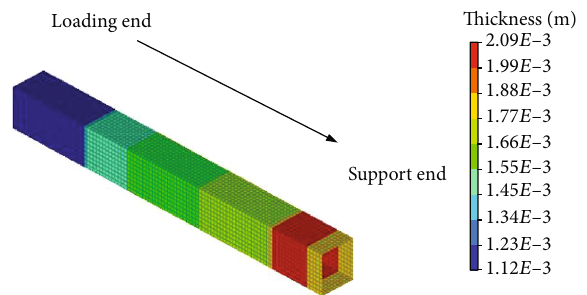
Figure 28: Thickness distribution of the TRB concept tube without transition zone.